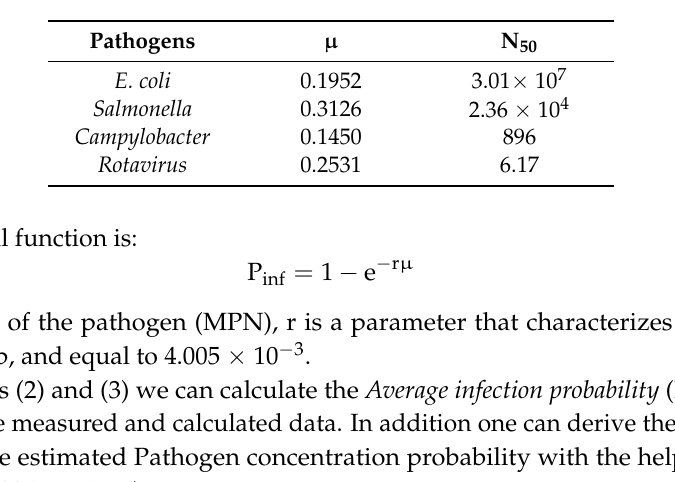
Table 1. µ and N 50 of E. coli , Salmonella , Campylobacter and Rotavirus [21].